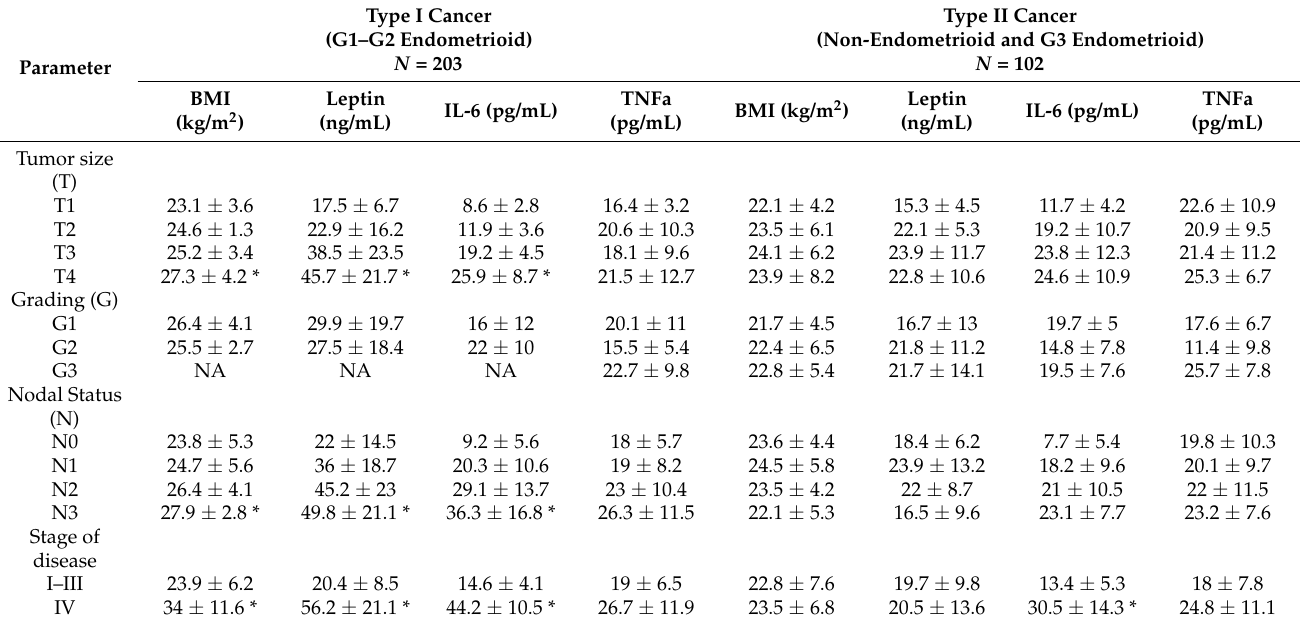
Table 4. Evaluation of BMI, leptin, and proinflammatory cytokines according to prognostic categories among endometrial cancer